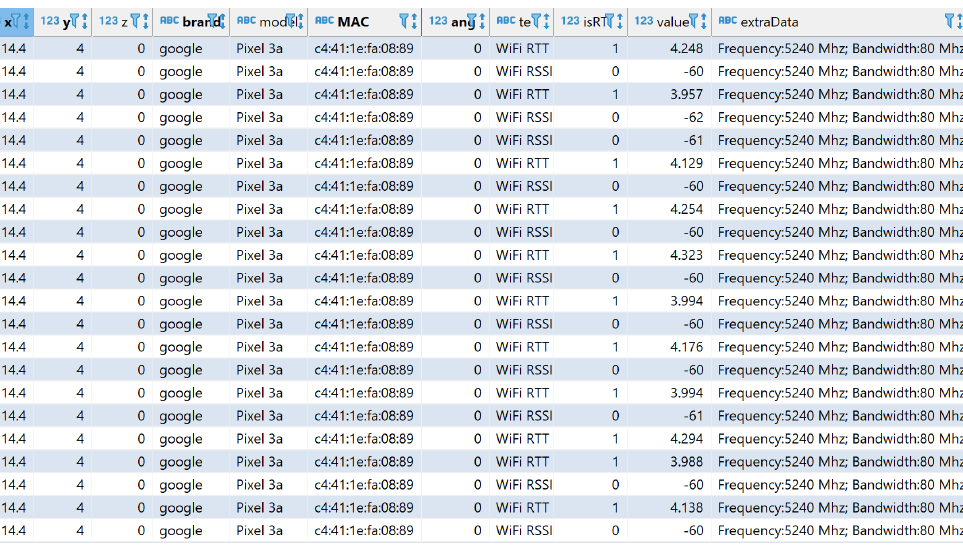
Figure 8. Variability of the observations at one single RP to a single AP, both in the case of “WiFi RTT” and “WiFi RSS” measurements. The feature named “value” represents, in the former, the average distance in meters and, in the latter case, the RSS in